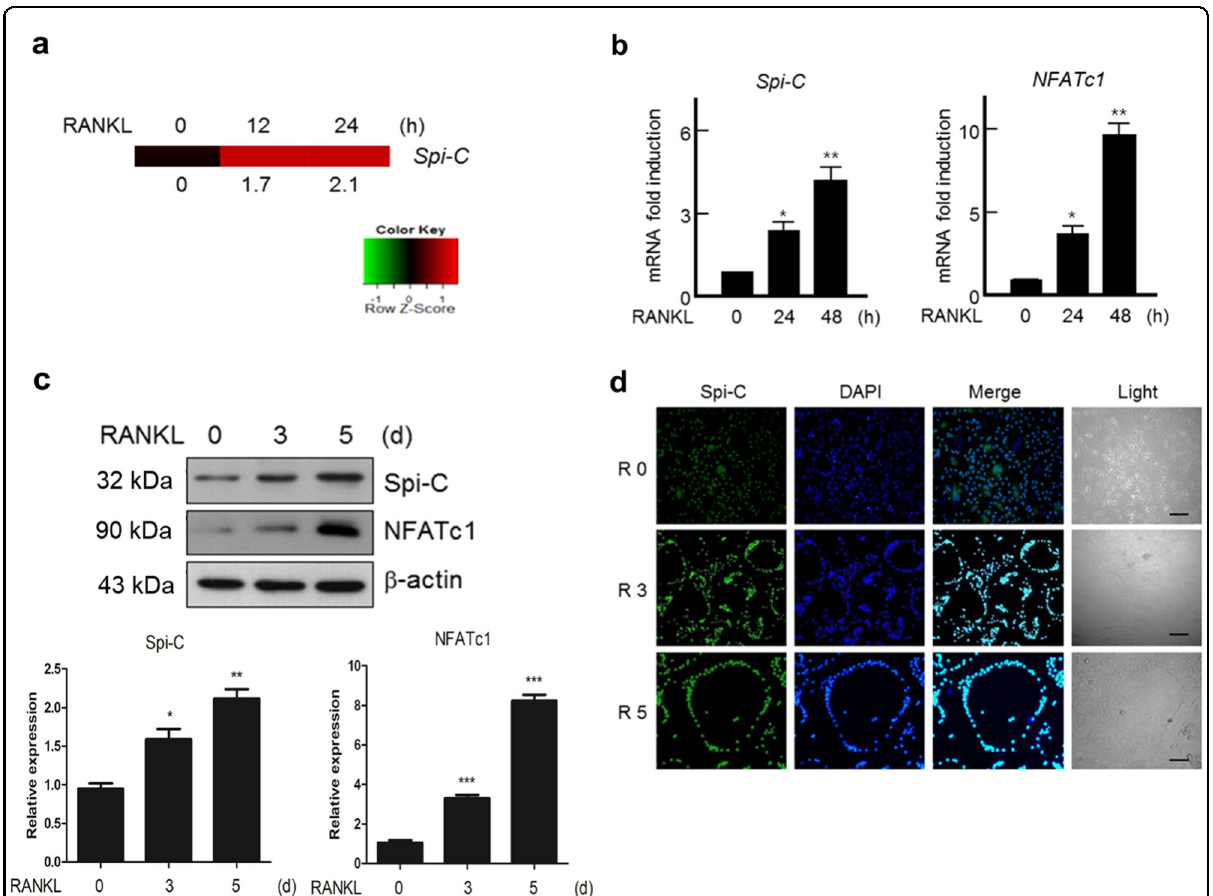
Fig. 1 Spi-C is upregulated during RANKL-mediated osteoclast differentiation. a Gene chip analysis result of the Spi-C gene in BMMs that were stimulated with RANKL for 12 h and 24 h. b qPCR analysis of the mRNA expression levels of Spi-C and NFATc1 in RANKL-stimulated BMMs at the indicated times. All quantitations were normalized to hprt expression. c Isolated BMMs were stimulated with RANKL (200 ng/ml) for the indicated times followed by lysis and western blot analysis with antibodies speci fi c to Spi-C, NFATc1, and β -actin (upper panels). The protein bands were quanti fi ed using densitometry, and the levels of Spi-C and NFATc1 were normalized to the levels of actin. The relative expression levels in the stimulated cells compared with the untreated cells are shown (lower panels). The data are presented as the mean ± SD of three independent experiments. * p < 0.05, ** p < 0.005 vs. nontreated cells. d BMMs stimulated with RANKL (200 ng/ml) for the indicated times were fi xed and then subjected to immuno fl uorescence staining for Spi-C. Spi-C was detected as green fl uorescence using FITC-conjugated secondary antibodies. The nuclei were stained blue with DAPI. These cells were observed and imaged under a fl uorescence microscope. Scale bars, 100 μ m (original magni fi cation,